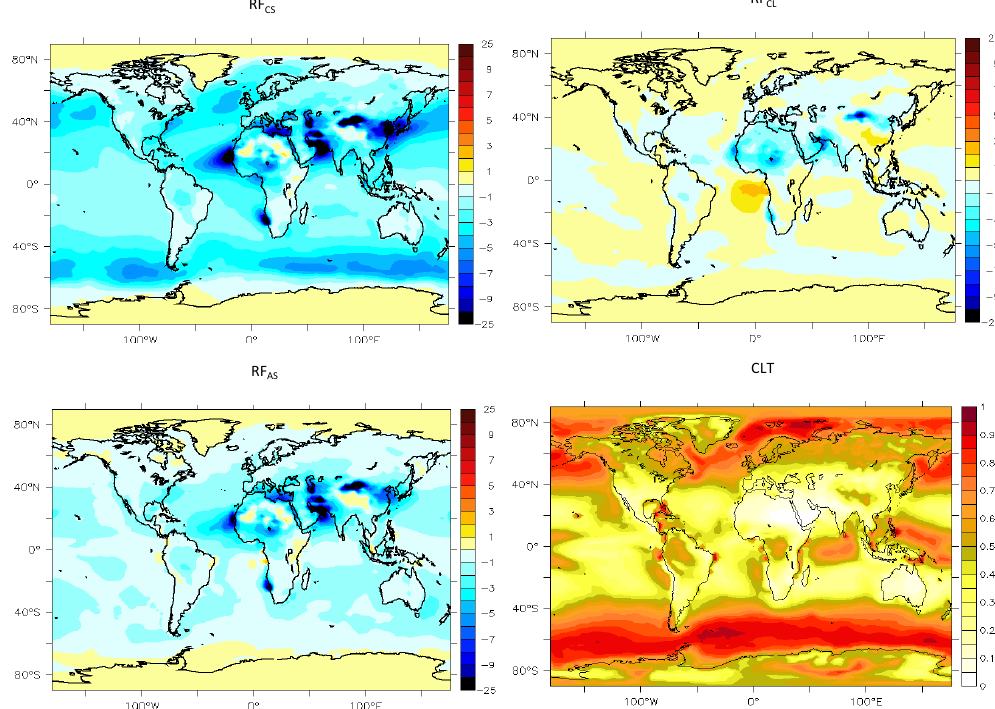
Fig. 2. All-aerosol (AER) radiative forcing in clear-sky (RF CS (Wm − 2 ), top left), cloudy-sky (RF CL (Wm − 2 ), top right) and all-sky (RF AS (Wm − 2 ), bottom left) conditions. Bottom right: cloud fraction